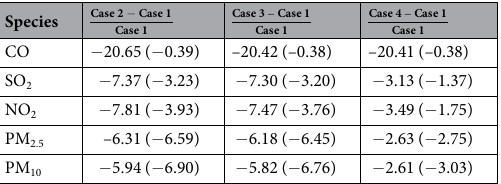
Table 2. Predicted annual percentage reductions and amounts * (in parentheses) of Cases 2, 3, and 4 relative to Case 1 in Beijing with a resolution of 4 × 4 km. * Units of CO are mg m − 3 and those of other species are µ g m − 3